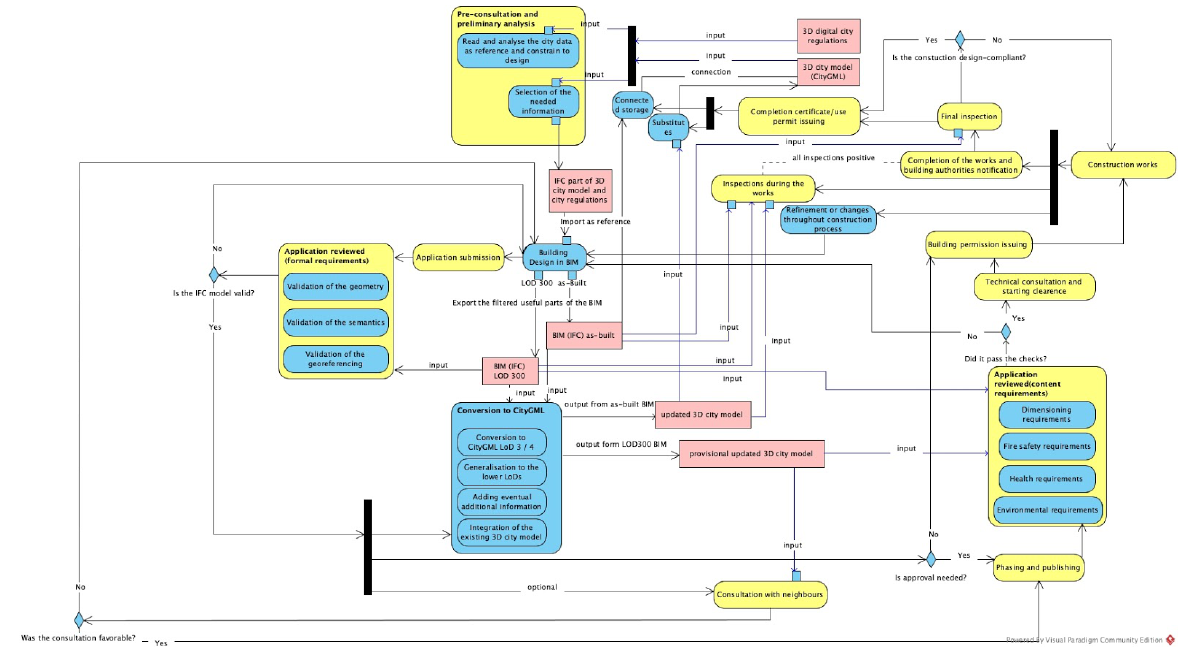
Figure 1 – Integrated Planning Workflow Diagram